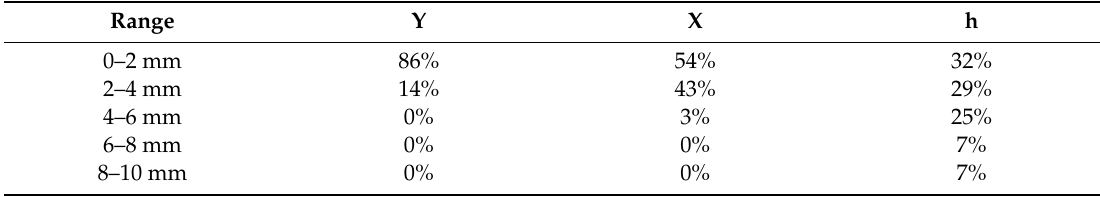
Table 4. Residual classification for G-baseline.